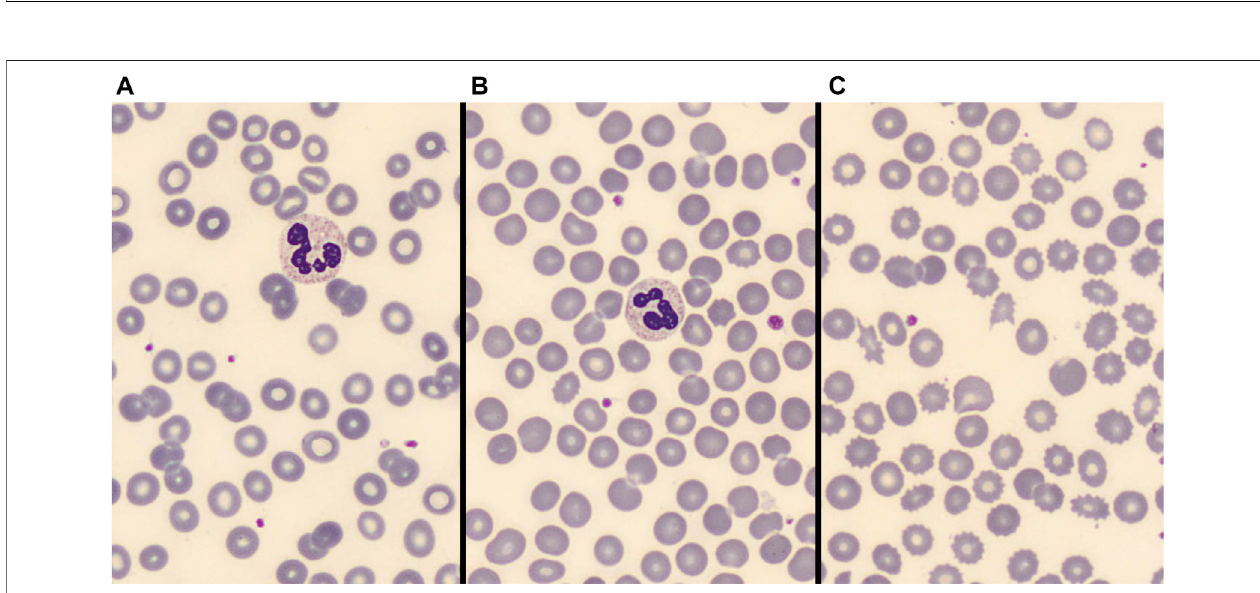
FIGURE 2 | (A) : no signi fi cative abnormal RBC morphologies. (B) : < 10% abnormal RBC morphologies. (C) : > 10% abnormal RBC morphologies.